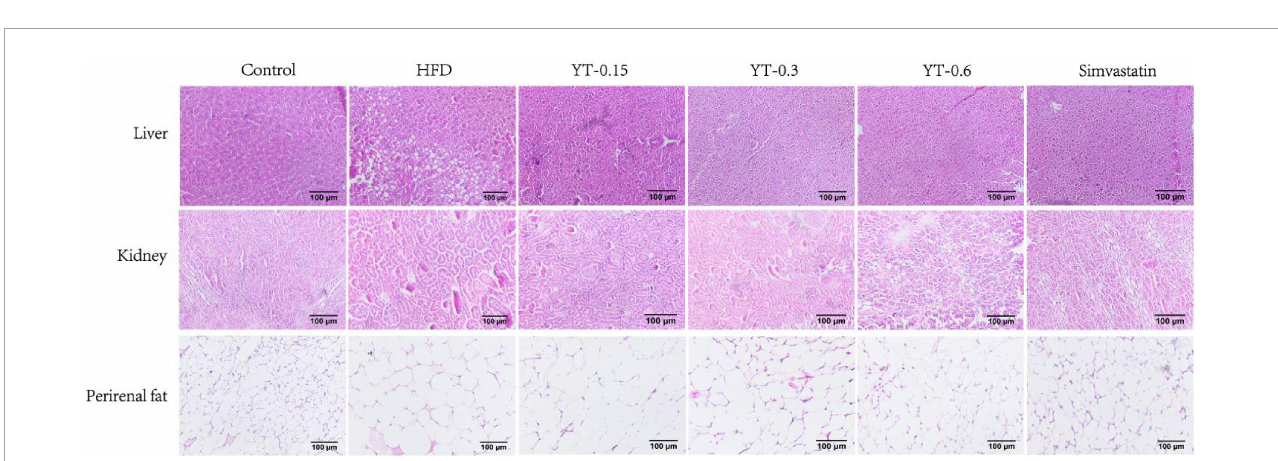
FIGURE4 Histological changes in the liver, kidneys, and perirenal fat of six experimental groups of mice. H&E-stained liver and fat tissue sections were observed using an optical microscope at × 400 magnification.